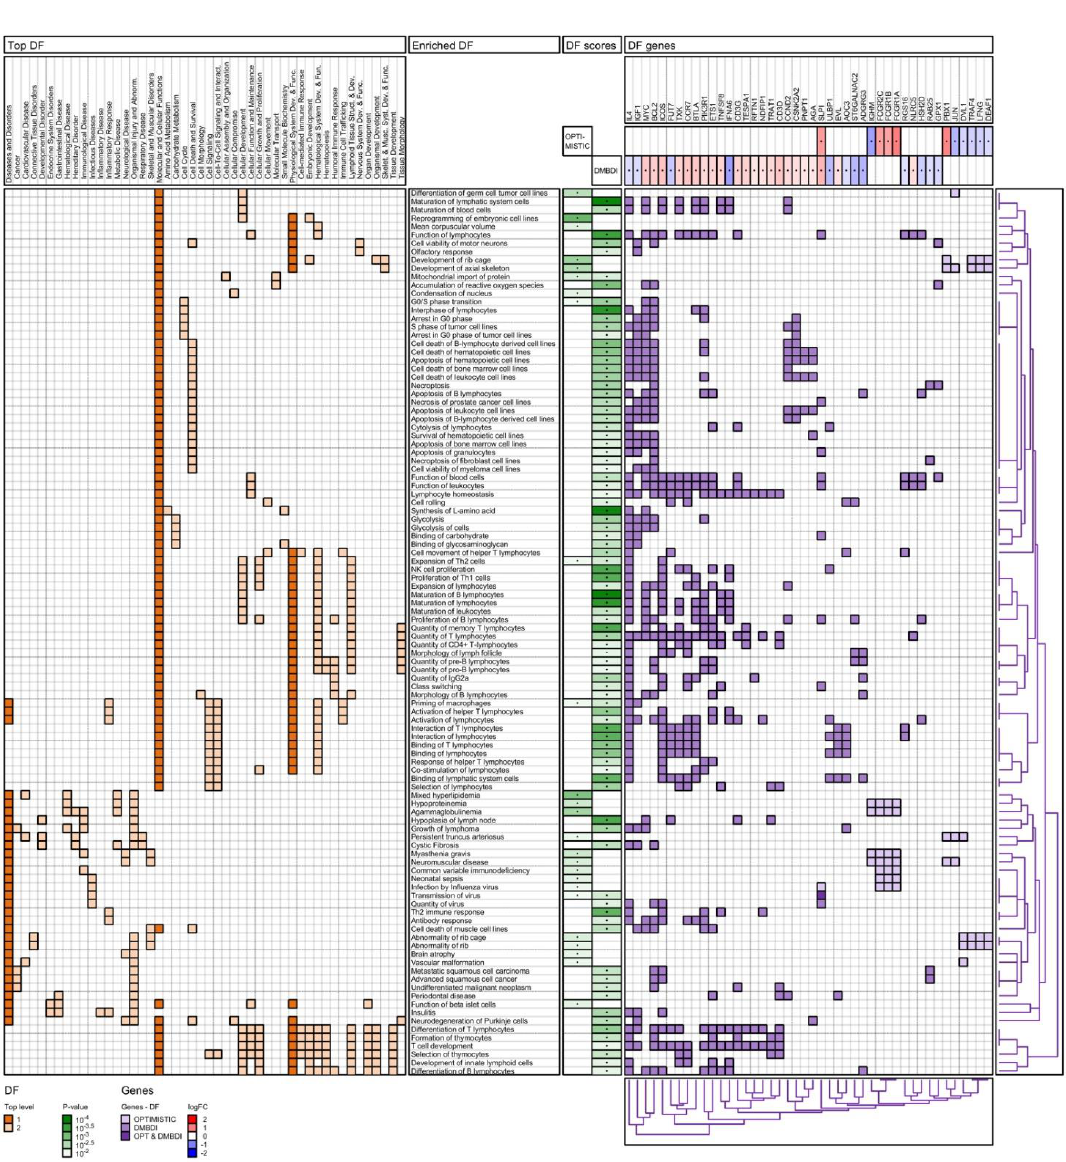
Figure 4. IPA diseases and functions (DF) enrichment analysis of OPTIMISTIC and DMBDI genes. For explanation see Section 2.4.